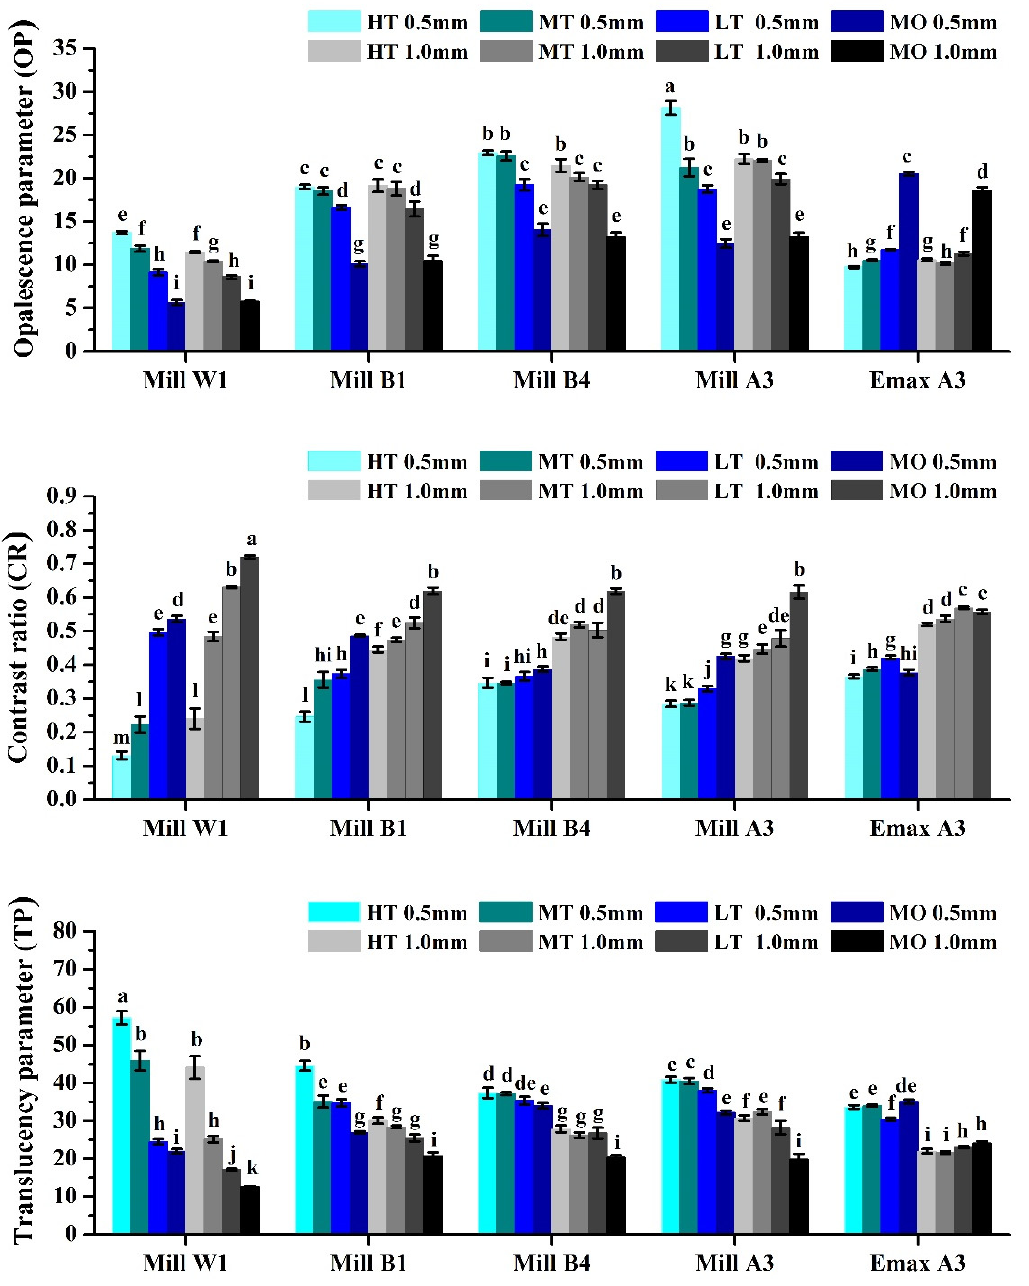
Figure 3. The translucency parameter, contrast ratio, and opalescence parameter of dental glass- ceramics systems. Means with different letters differ significantly ( p < 0.05, mean ± SD, n = 10).